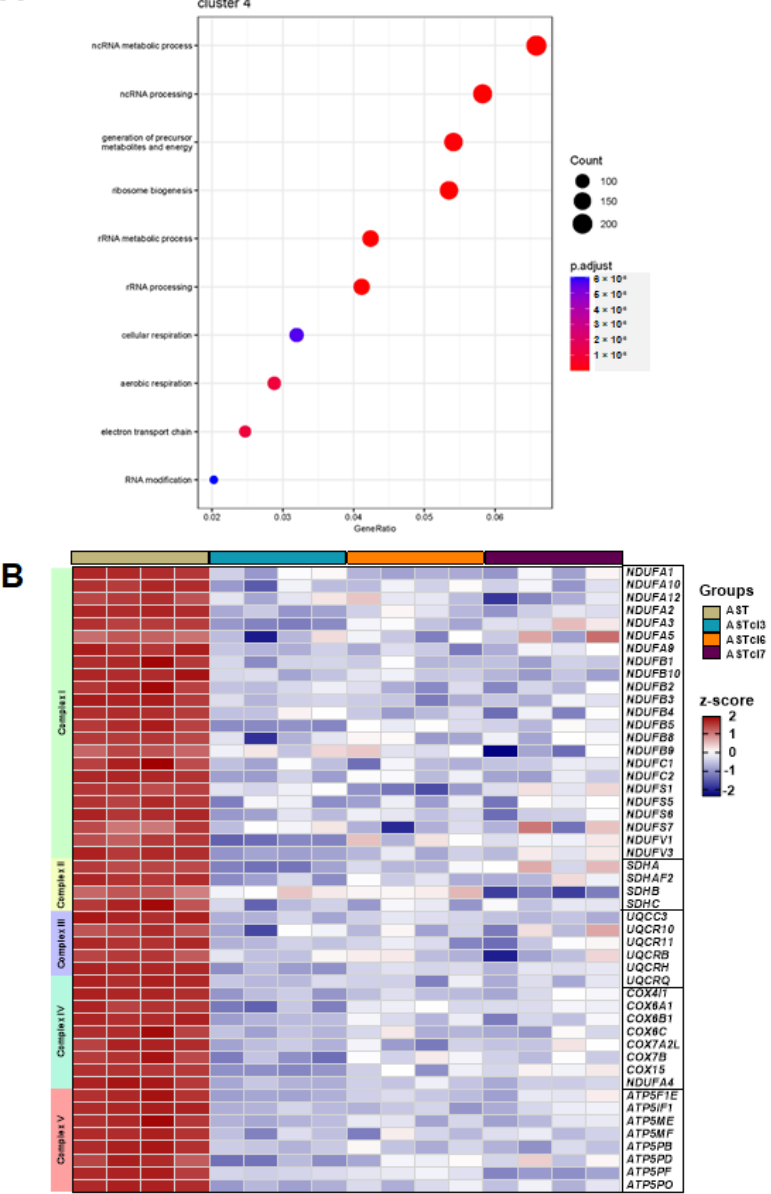
Figure 7. Transcriptome analysis of astrocyte-derived cells: ( A ) Dot plot of the 10 most enriched GO processes of cluster 4 (Figure S3). ( B ) Heatmap representing the expression of genes coding for components of subunits of the five complexes of oxidative phosphorylation presented in the GO: generation of precursor metabolites and energy (GO 6091), cellular respiration (GO 45333), aerobic respiration (GO 9060), and the electron transport chain (GO